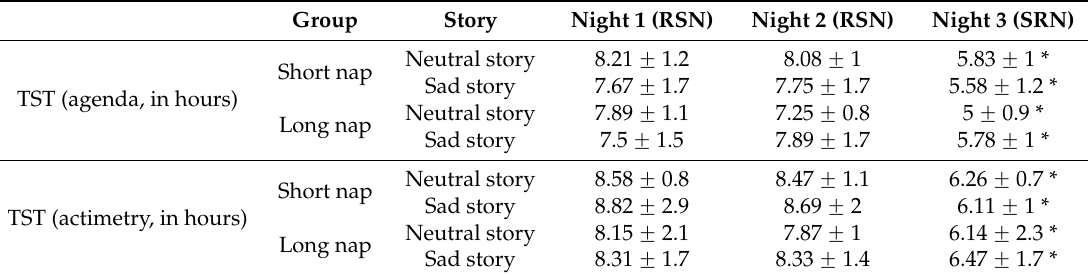
Table 1. Subjective and objective Total Sleep Time (mean ˘ SD, hours), derived from sleep agendas and actimetry, respectively. Data were obtained during the three nights preceding the testing